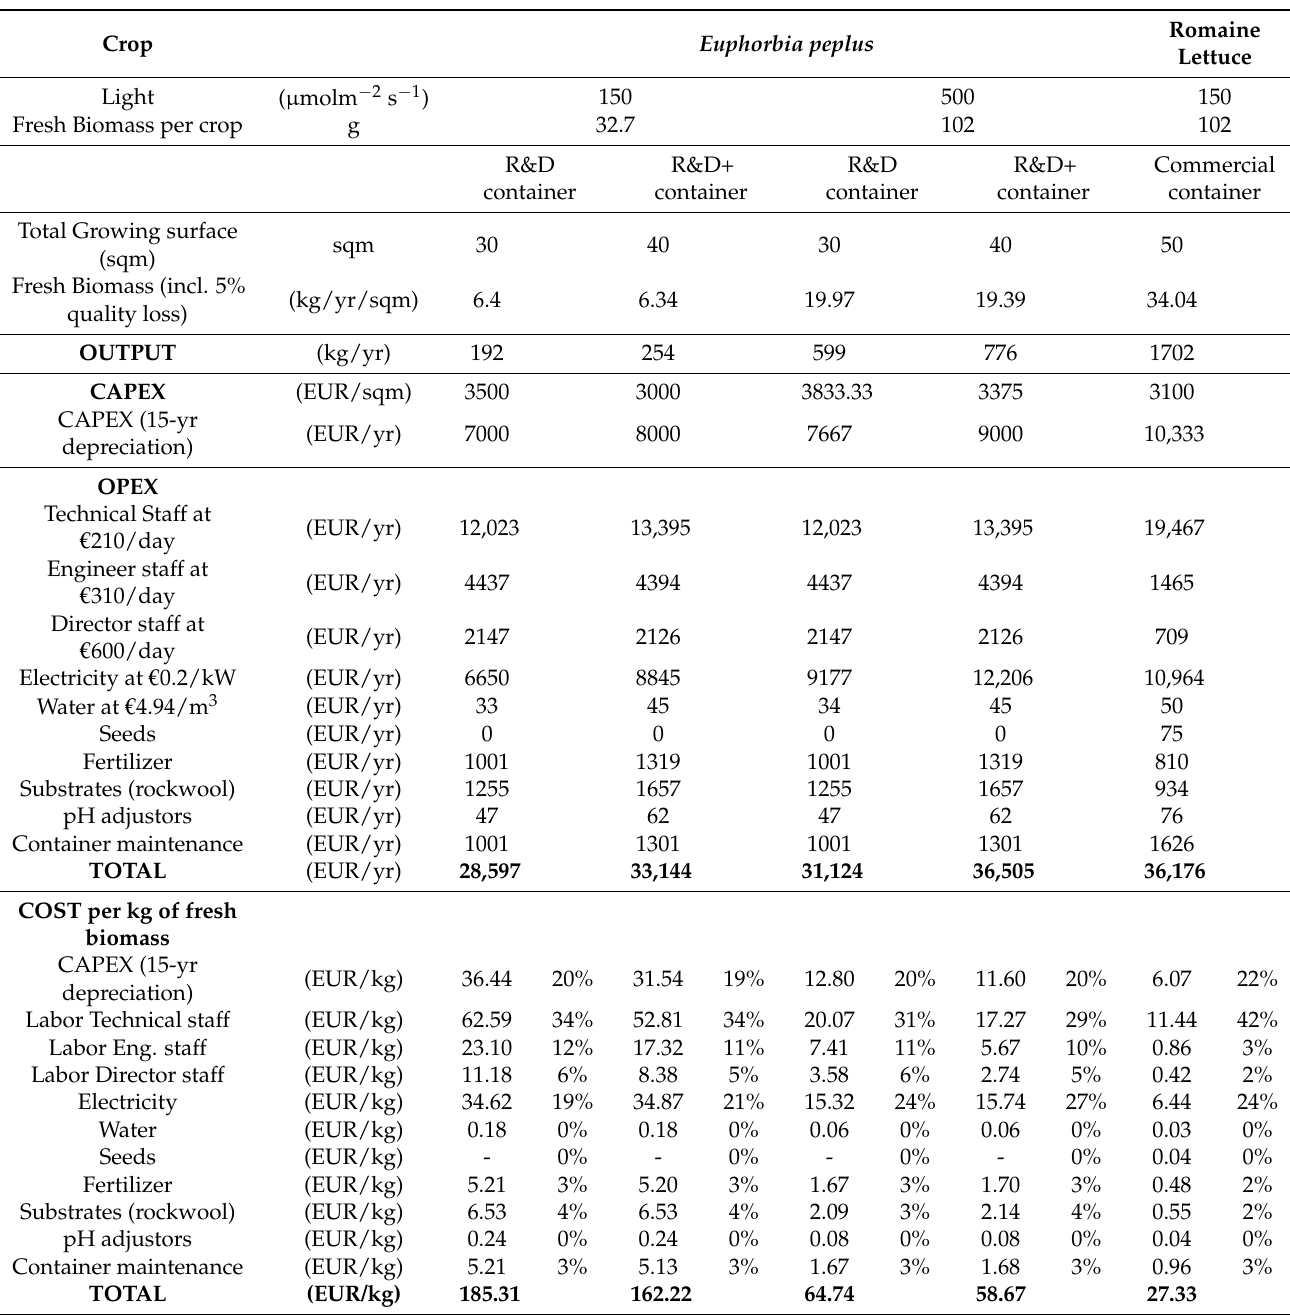
Table 3. Cultivation costs of Euphorbia peplus and Romaine lettuce in several scenarios according to the light intensity and growing surface, generating fresh biomass, output, capex, and opex. The cost per kg of fresh biomass includes capex and opex; the contribution of each particular cost to the total cost was calculated as a percentage. The values mentioned under the “R&D” container are experimental results, and the values mentioned under the “R&D+” container and “Commercial container” are projected